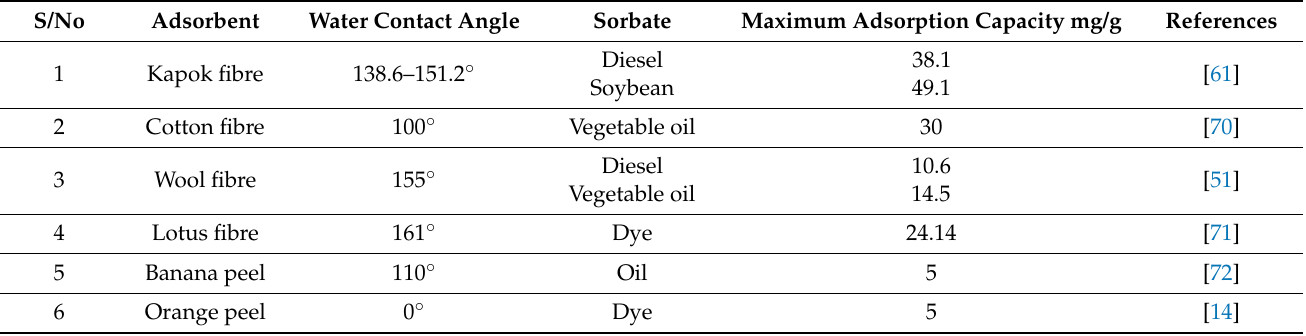
Table 2. Water contact angle of some sorption lignocellulose